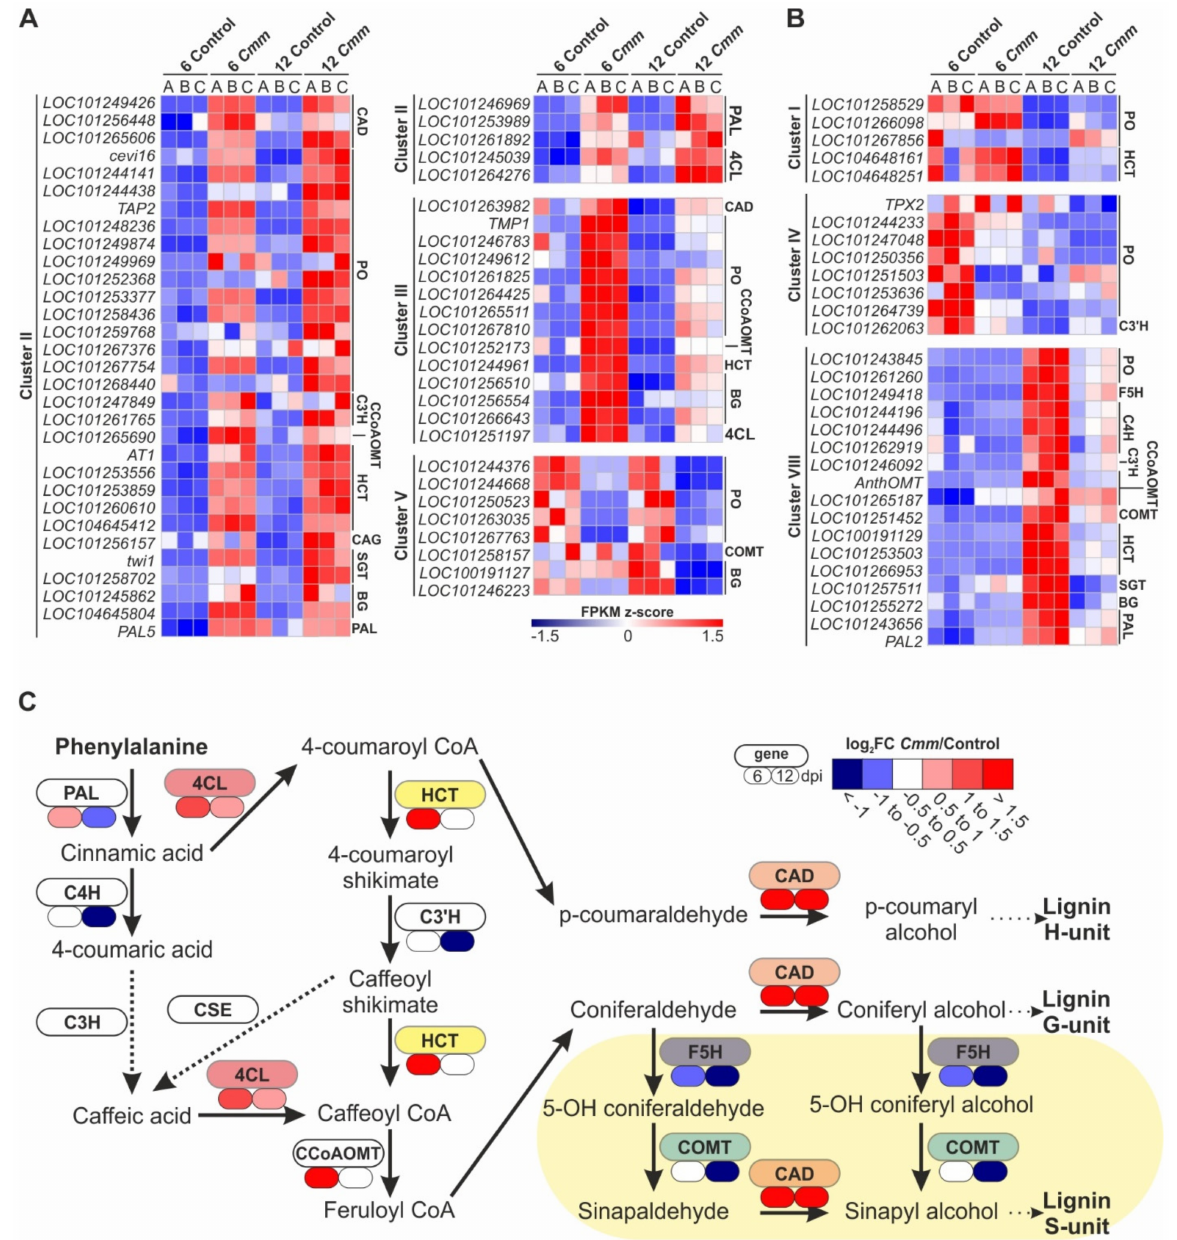
Figure 8. Cmm infection differentially regulated the tomato phenylpropanoid biosynthetic pathway genes. ( A , B ) Heat map of tomato DEGs involved in phenylpropanoid metabolism. ( A ) Genes within Clusters II, III and V that were constantly up- or down-regulated at both time points of Cmm infection. ( B ) Additional genes of the pathway without a constant expression pattern enclosed in Clusters I, IV and VIII. ( C ) Presentation of the relative expression change of genes encoding key enzymes of the monolignol biosynthesis pathway. In phenylpropanoid metabolism, the genes that were differentially expressed upon Cmm infection leading to hydroxycinnamyl alcohols which are polymerized into lignin are: L-Phenylalanine Ammonia-Lyase ( PAL ), Cinnamic acid 4-Hydroxylase ( C4H ), 4-hydroxycinnamate CoA Ligase ( 4CL ), Hydroxycinnamoyl CoA:shikimate hydroxycin- namoyl Transferase ( HCT ), Coumaroyl shikimate 3 (cid:48) -Hydroxylase ( C3 (cid:48) H ), Caffeoyl CoA 3-O-MethylTransferase ( CCoAOMT ), Ferulic acid/coniferaldehyde 5-Hydroxylase ( F5H ), Caffeic acid/5-hydroxyconiferaldehyde 3/5-O-MethylTransferase ( COMT ) and Cinnamyl Alcohol Dehydrogenase ( CAD ). The lower branch of the pathway demonstrating the suppressed genes at 6 dpi, modulating the synthesis of syringyl (S) lignin units, is